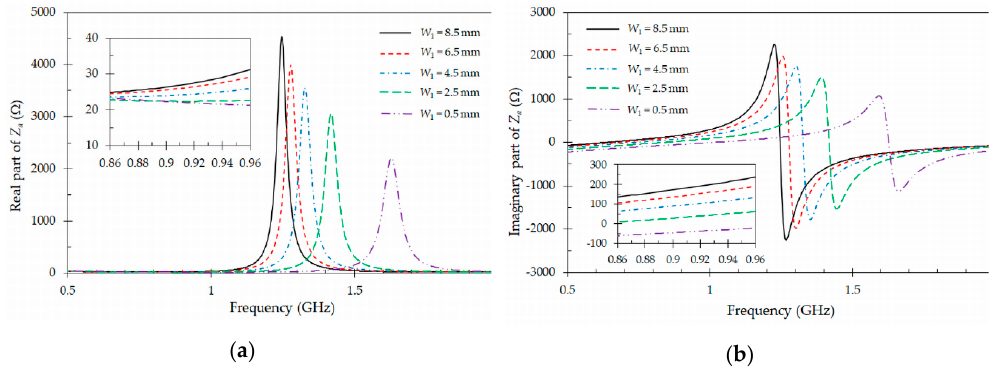
Figure 4. Simulated input impedance Za of the designed tag antenna (Figure 2b) for different values of W 1. ( a ) Real part of Za ; ( b ) Imaginary part of Za . The other dimensions are defined in Table 1.